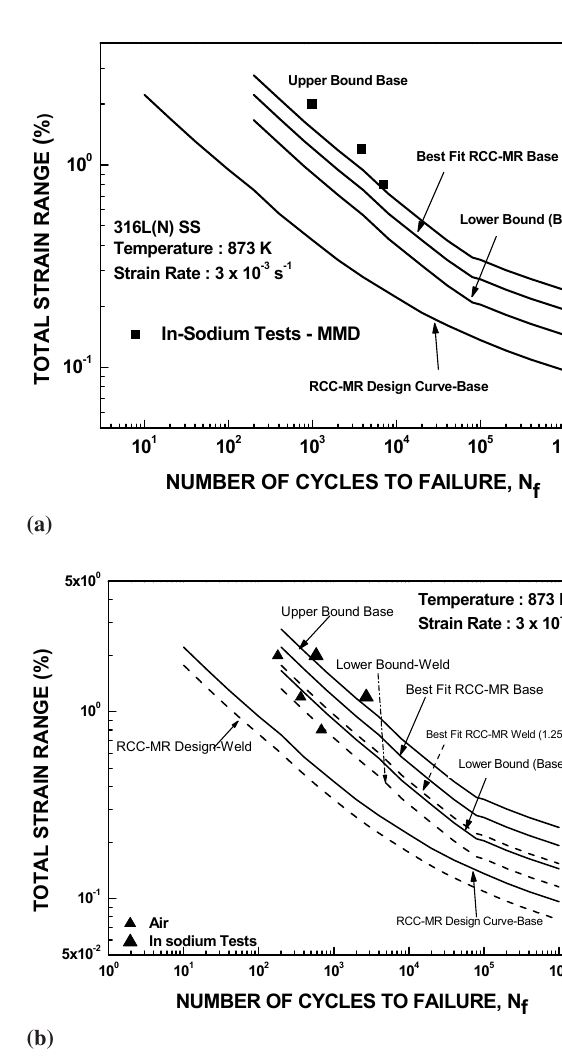
Figure 8. (a) Comparison of data with RCC-MR codes for the 316L(N) base metal; (b) Comparison of data with RCC-MR codes for the 316L(N) Weld